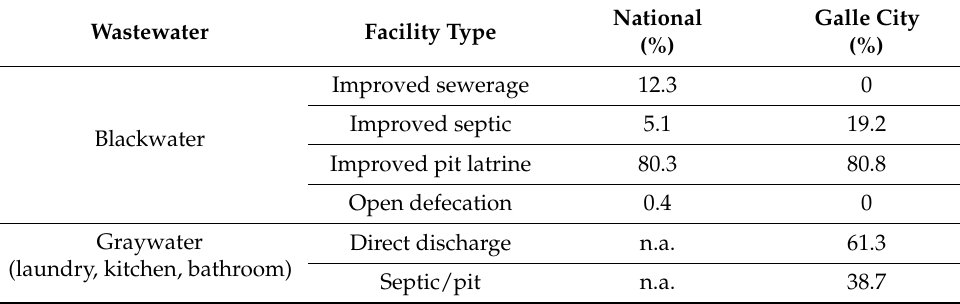
Table 1. Distribution of sanitation infrastructure nationally [20] and in Galle City (this